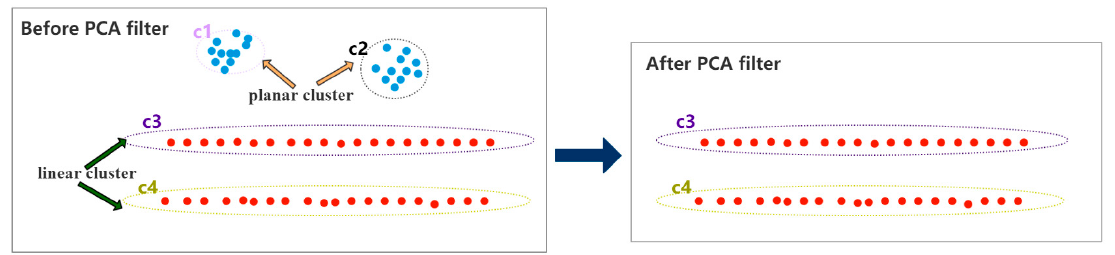
Figure 7. Euclidean distance cluster and principal component analysis (PCA) filter.